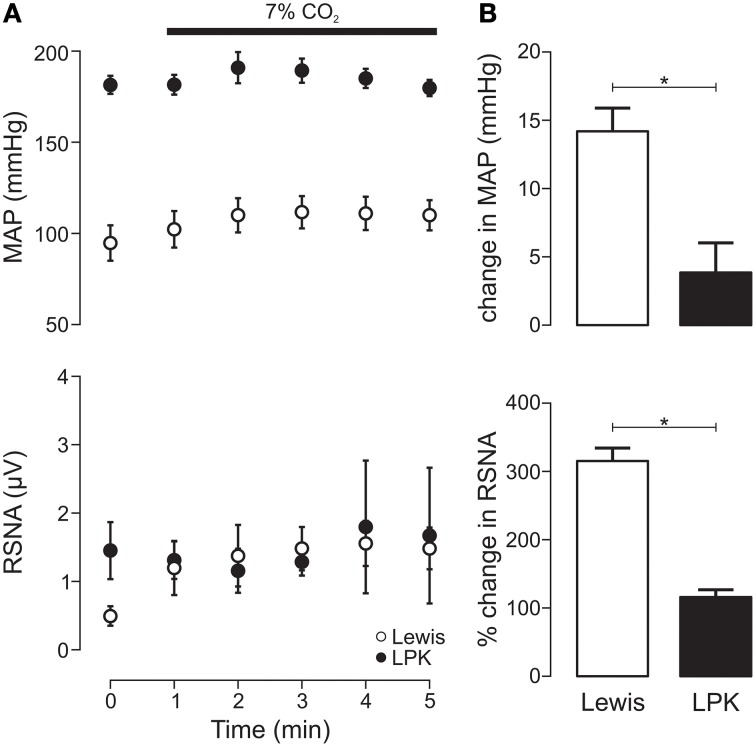
Mean arterial pressure (MAP) and renal sympathetic nerve activity (RSNA) responses to central chemoreflex activation in Lewis and Lewis Polycystic Kidney (LPK) rats. (A) Data points are 1-min averages of RSNA and MAP measured for 1 min before (time zero) and 5 min during a hypercapnic challenge (7% CO2). (B) average change in MAP and RSNA during the challenge. Results are expressed as mean ± SEM. *p < 0.05. Minimum n/group = 4.